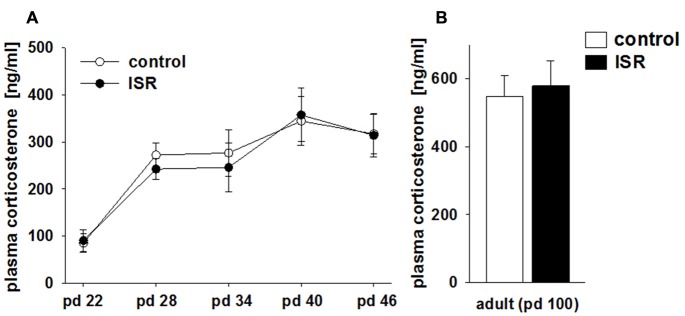
Comparison of blood corticosterone levels in adolescent (A) and adult (B) females of the adequate (control) and the ISR condition. Baseline corticosterone levels in rats of both rearing conditions did not differ over the course of adolescence between the two rearing conditions. Data are indicated as means ± SEM (control/ISR: n = 8 each).